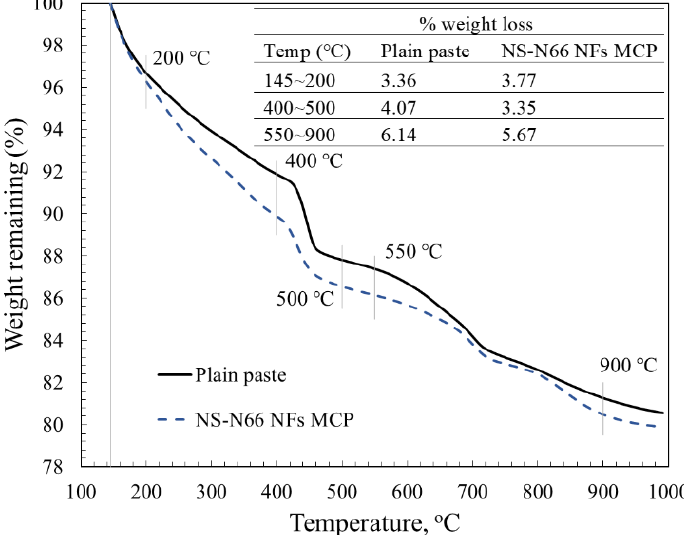
Figure 8. TGA-DTG results of the hardened cement pastes.